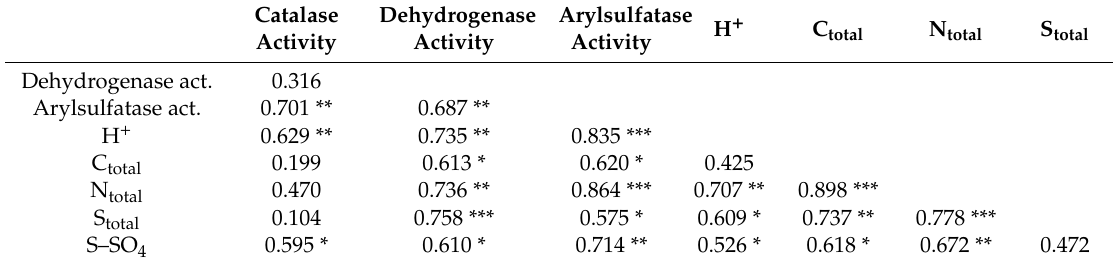
Table 5. Values of correlation coe ffi cient between soil